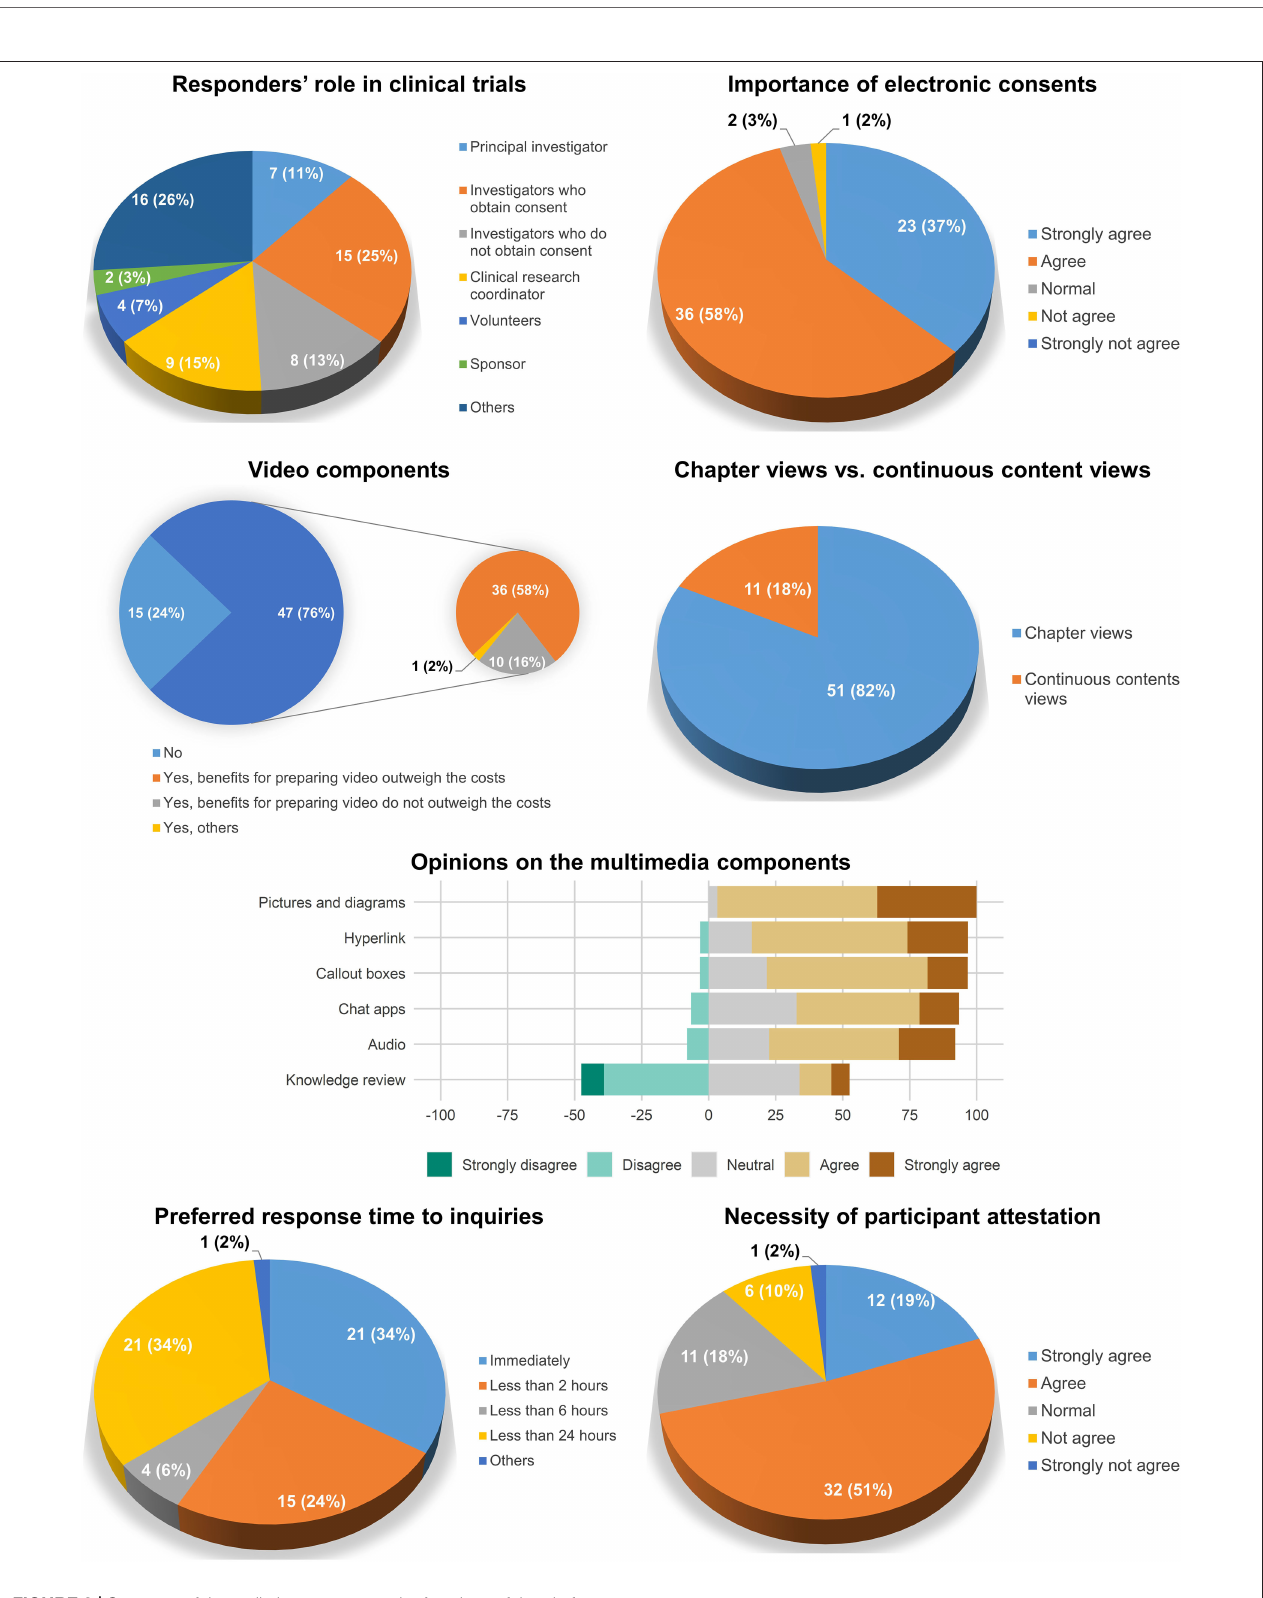
FIGURE 3 | Summary of the preliminary survey on the functions of the platform.